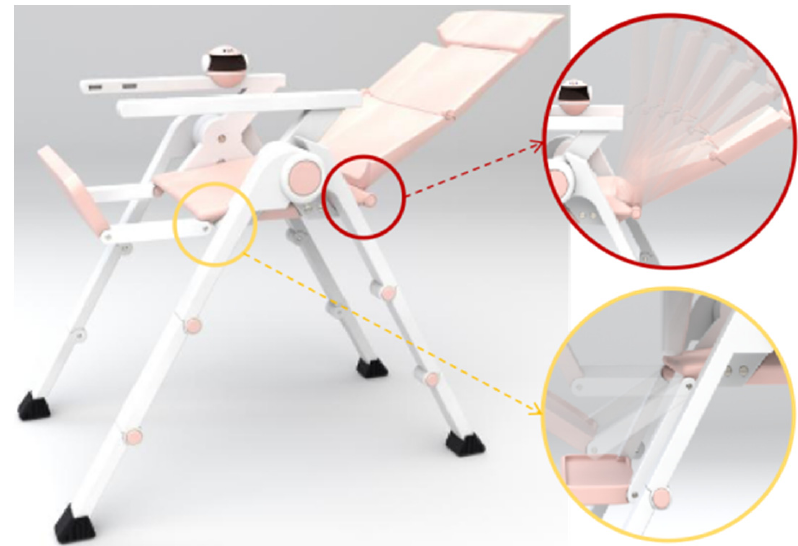
Figure 10. The two controllable joints of the baby chair.